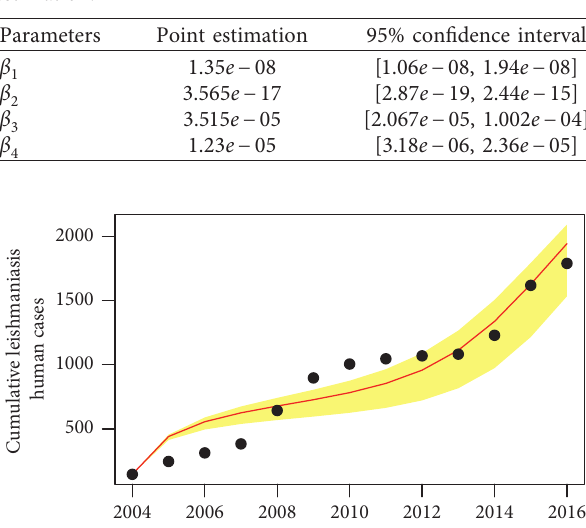
Table 2: Parameter values for point estimation and 95% interval estimation.